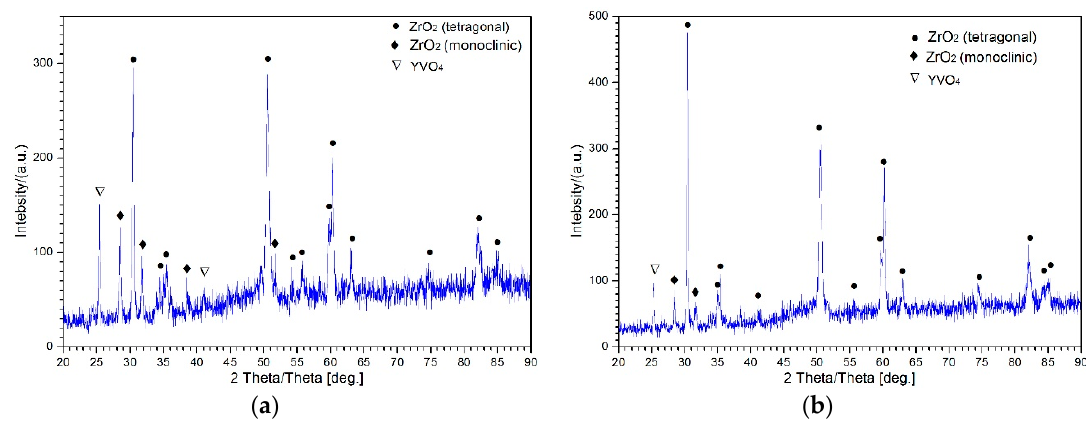
Figure 4. XRD patterns of ceramic hole walls: ( a ) unrepaired, ( b ) repaired with an HF-fs laser after hot corrosion.